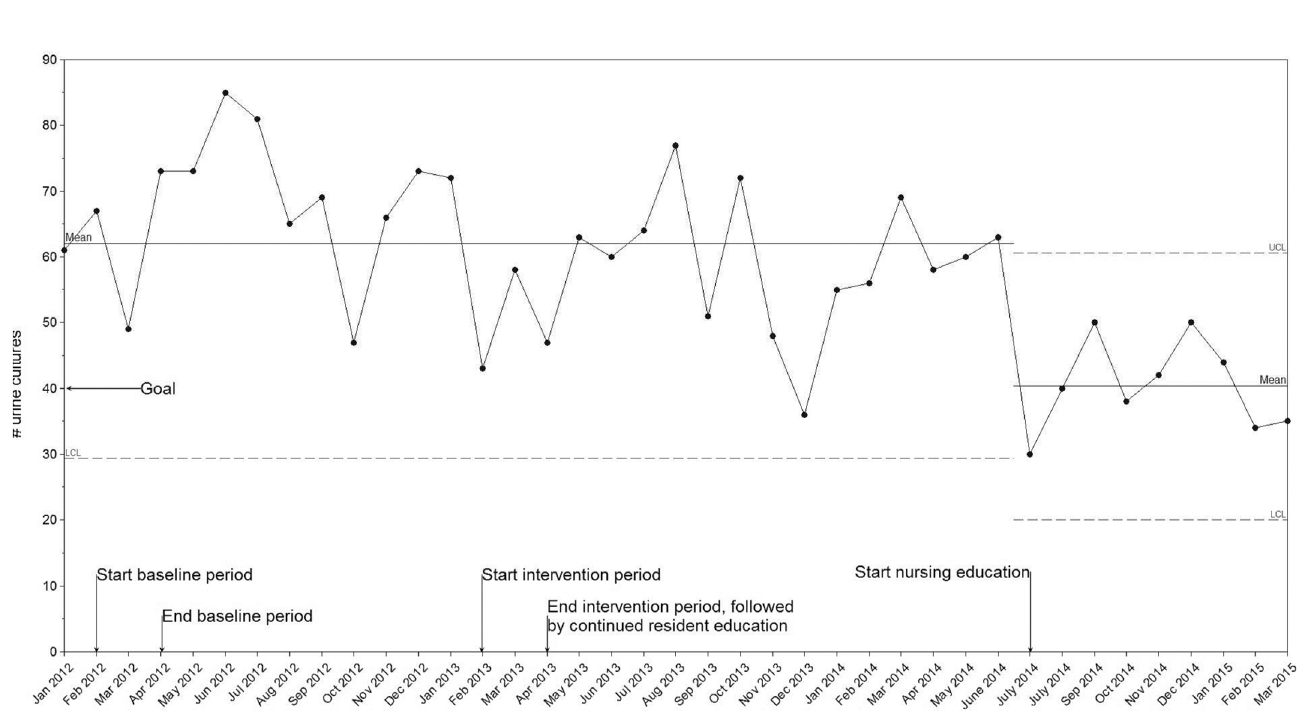
Fig 4. Time series data showing the monthly number of urine cultures ordered on intervention unit (i-chart).